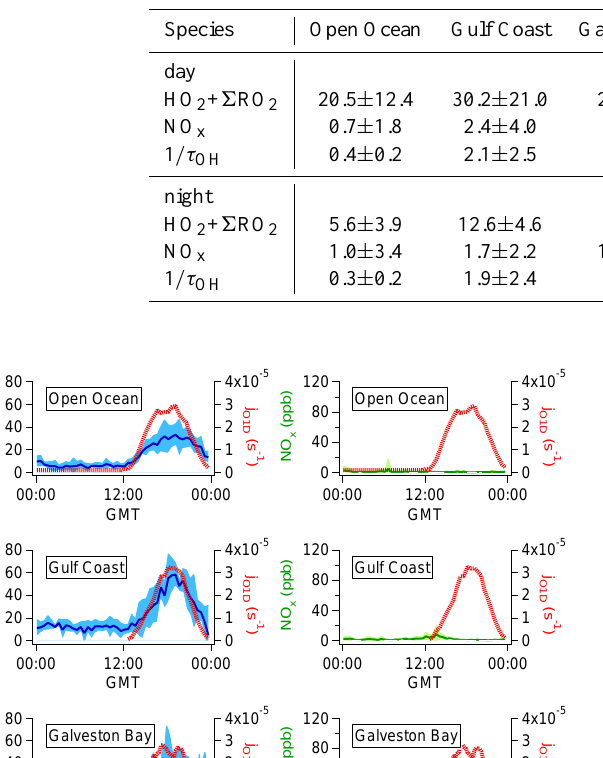
Table 1. Day-time (08:00-20:00) and night-time averages and standard deviations of HO 2 + 6 RO 2 (in ppt), NO x (in ppb) and total OH reactivity of VOC (1 /τ OH in s − 1 ) measured at different locations during the R/V Brown cruise.